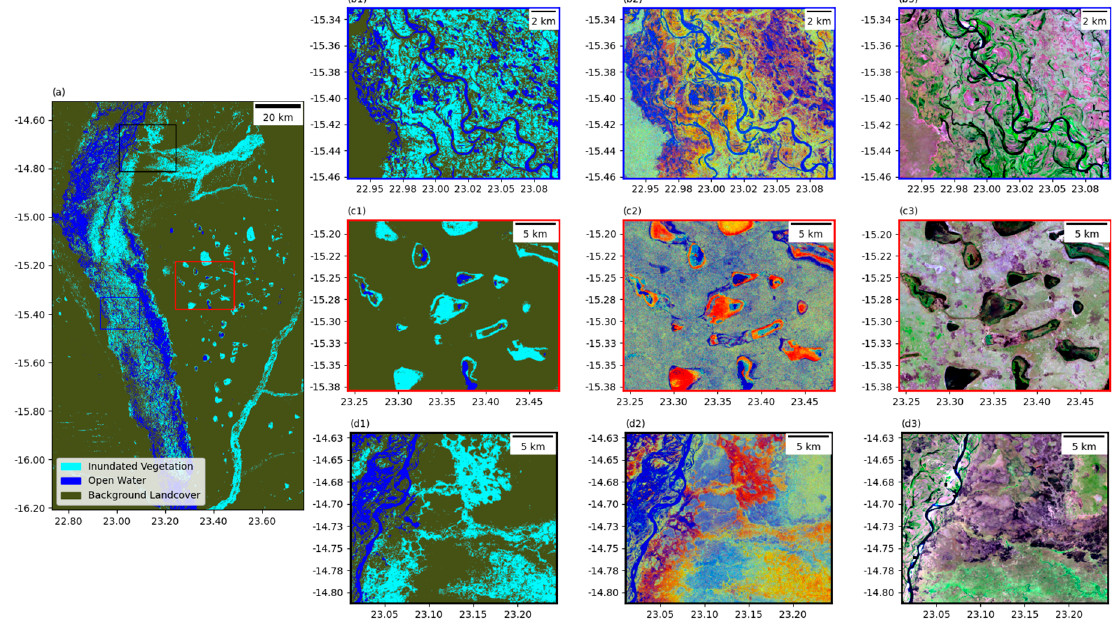
Figure 7. Example of RadWet wet season classified output over the Barotseland Floodplain dated 19 April 2020 ( a ). Subset figures represent the RadWet classified output, at representative locations includ- ing Sentinel-1 imagery used for the classification, and reference Sentinel-2 optical image. Specifically, ( b1 – b3 ) is a section of the main Zambezi channel and surrounding river features; ( c1 – c3 ) represents dambo features atop the eastern escarpment; and ( d1 – d3 ) is the location of the in-flow of the Leuna floodplain into the main Barotseland